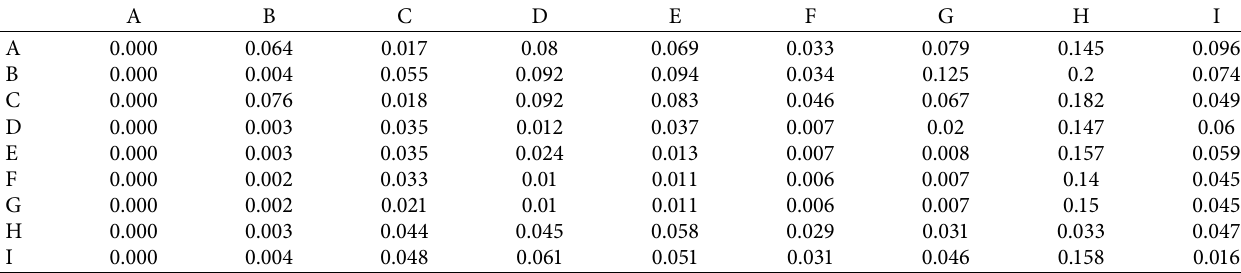
Table 17: The comprehensive influence